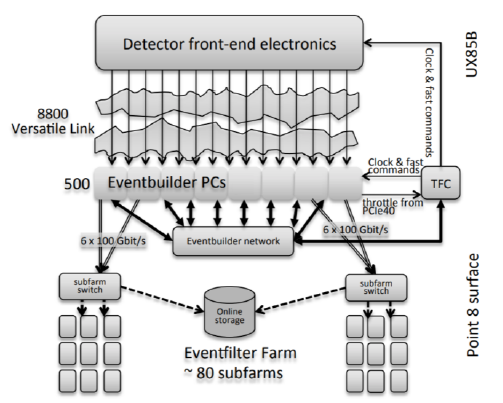
Figure 3. General structure of upgraded LHCb data acquisition system. The PCIe40 cards lie in the eventbuilder